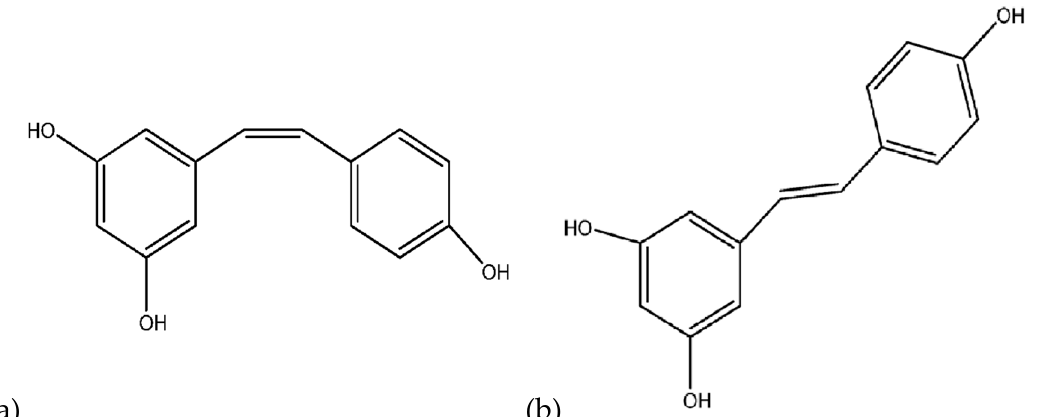
Figure 1. The two isomers of resveratrol; ( a ) cis-resveratrol and ( b ) trans-resveratrol [37].